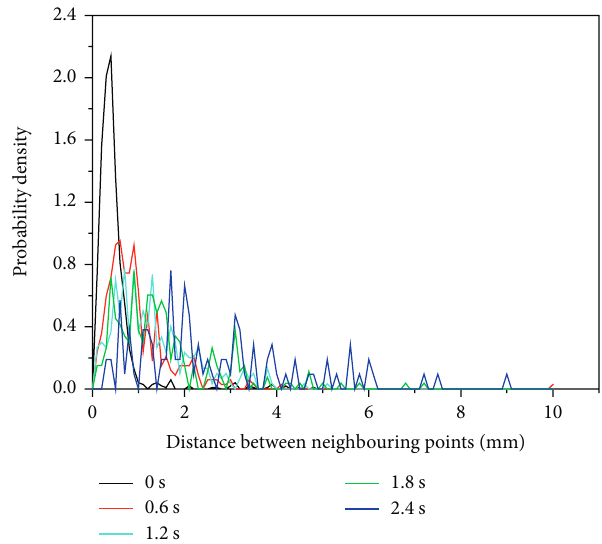
Figure 6: Distribution functions of distance between neighbouring points at different